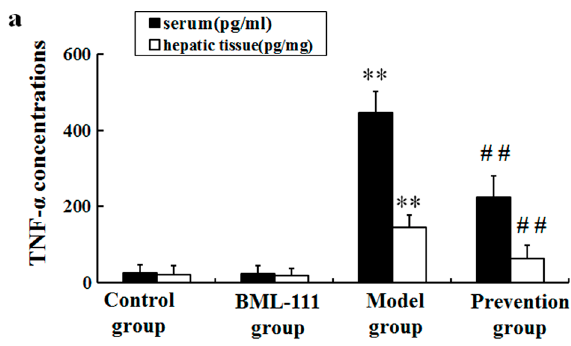
Figure 3. Cont. Figure 3.